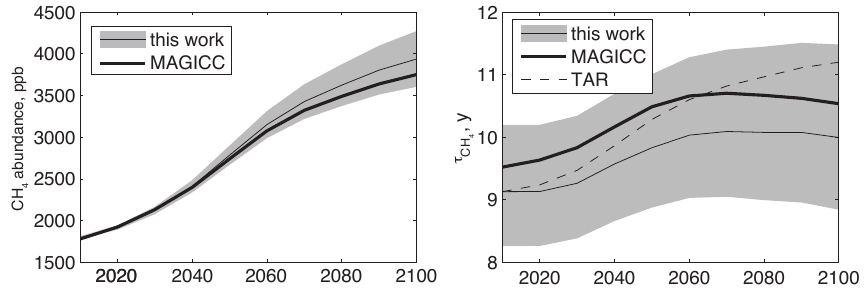
Fig. 7. Projected future methane abundance (left) and total lifetime (right) for RCP 8.5. Projected uncertainty (shaded) is the standard deviation from 10 5 monte carlo integrations, accounting for uncertainty in the present-day budget, emissions, and climate-chemistry effects on τ CH . Our projections are compared to MAGICC model (Meinshausen et al., 2011a) and the IPCC TAR formula (Prather et al., 4 × OH 2001).